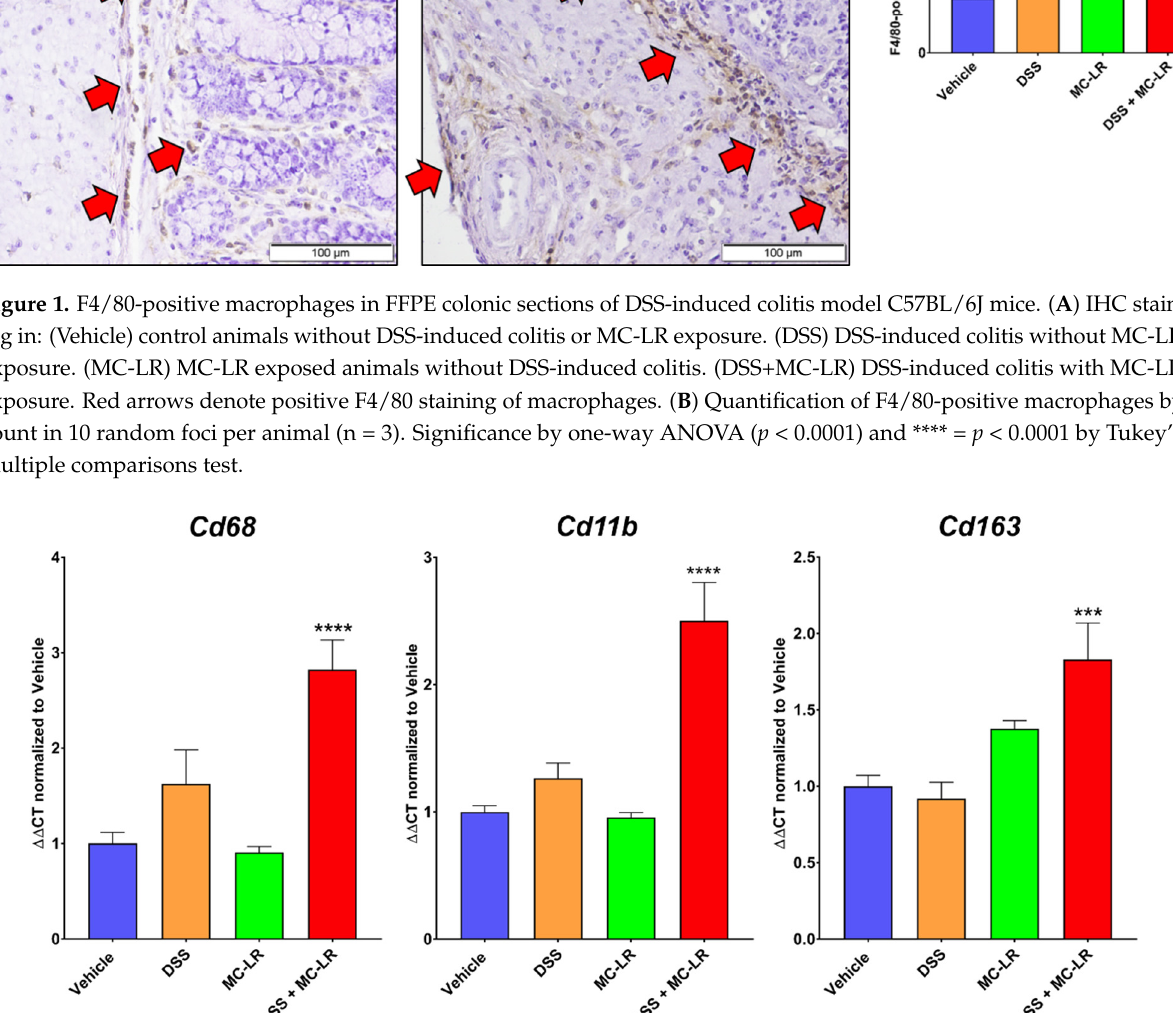
Figure 2. RT-PCR analysis for macrophage markers Cd68 , Cd11b , and Cd163 in colonic tissue from C57BL/6J mice. All values are normalized to housekeeping gene 18s and presented as the mean fold change relative to Vehicle healthy mice ± SEM (n = 6–10 mice per group). *** p < 0.001 and **** p < 0.0001 vs. the control Vehicle group by one-way ANOVA with Tukey’s multiple